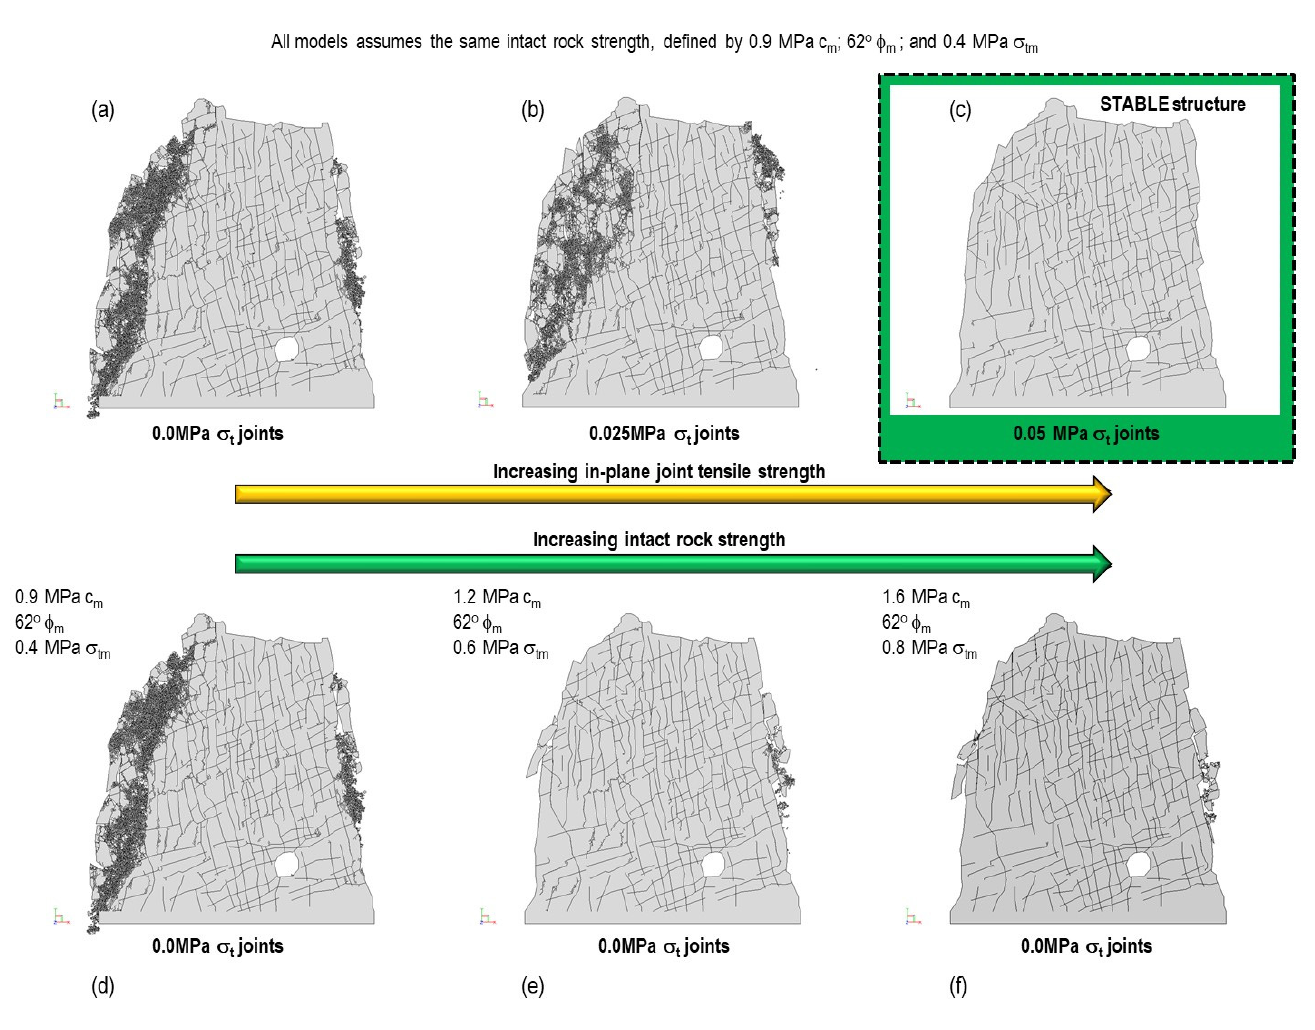
Figure 16. Simple modelling experiment using data from [1] that demonstrates the importance of determining accurate strength values for in-plane rock bridges. Models ( a – c ) have the same intact rock strength but increasing tensile strength for the fracture traces. Models ( d – f ) show that increasing intact rock strength under the assumption of 0 MPa tensile for the fracture traces is not sufficient to yield stable conditions for the rock mass.